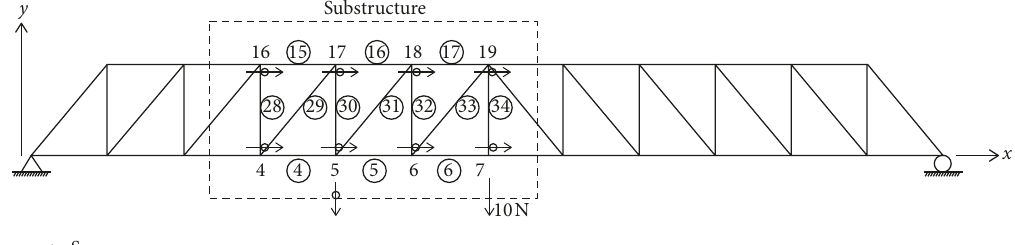
Figure 12: A substructure isolated from the entire truss